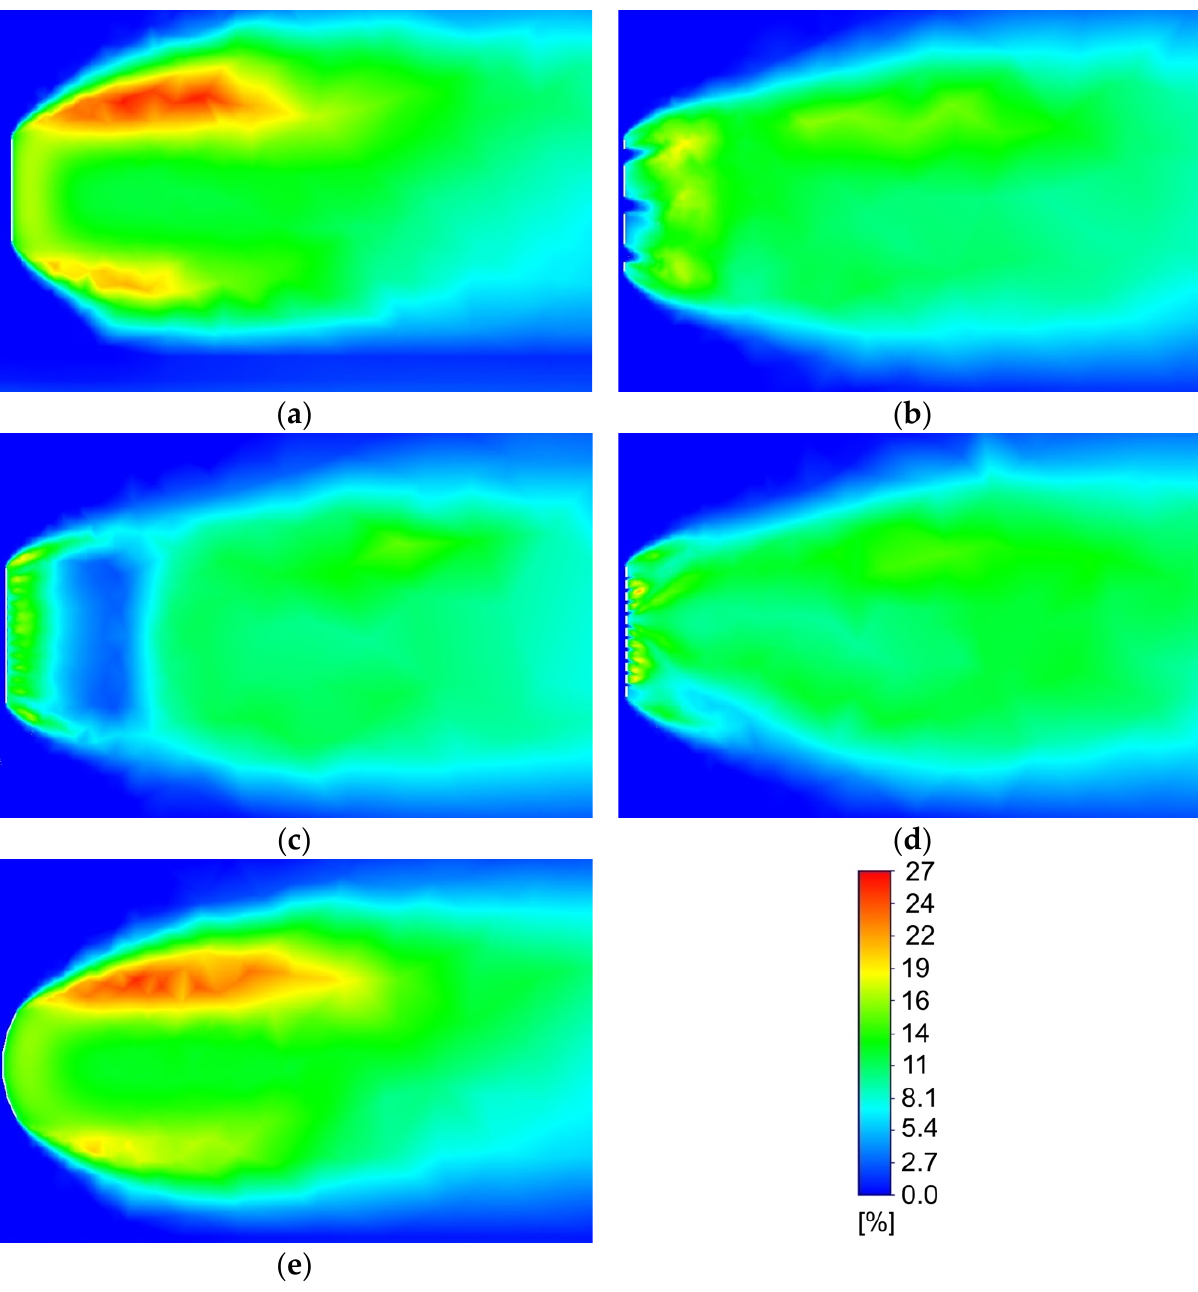
Figure 8. Contours of turbulence intensity around: ( a ) standard panel, ( b ) 28 staggered holes, ( c ) 200 uniform square holes, ( d ) 10 rectangular slots, and ( e )